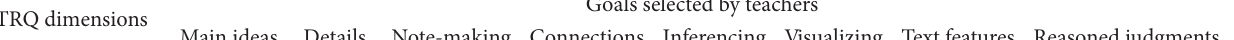
T 7: Correlations between implementation quality and LTRQ gains for goals selected by